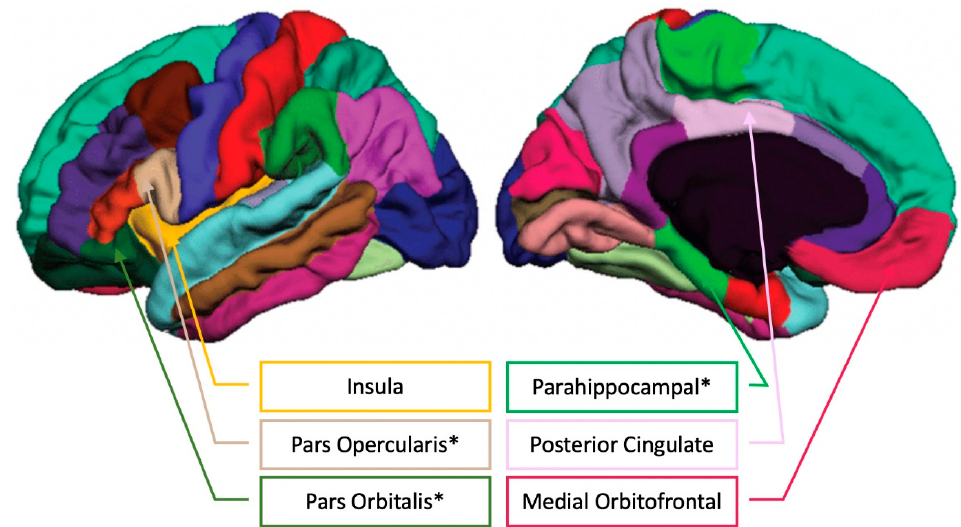
Figure 5. FreeSurfer cortical parcellations with the regions showing positive correlations between Musical Training (Gold-MSI) and brain volume in older adults (the unlabeled FreeSurfer cortical parcellation image) [42]. * indicates passing the Benjamini–Hochberg correction for multiple comparisons.